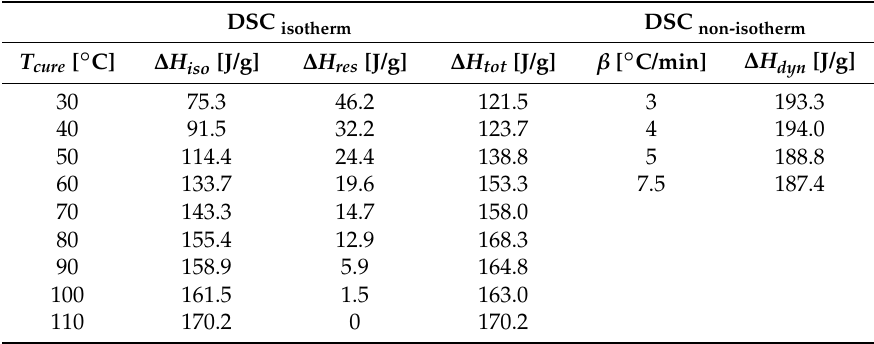
Table 2. Kinetic parameters obtained during isothermal and non-isothermal DSC measurements. DSC isotherm DSC